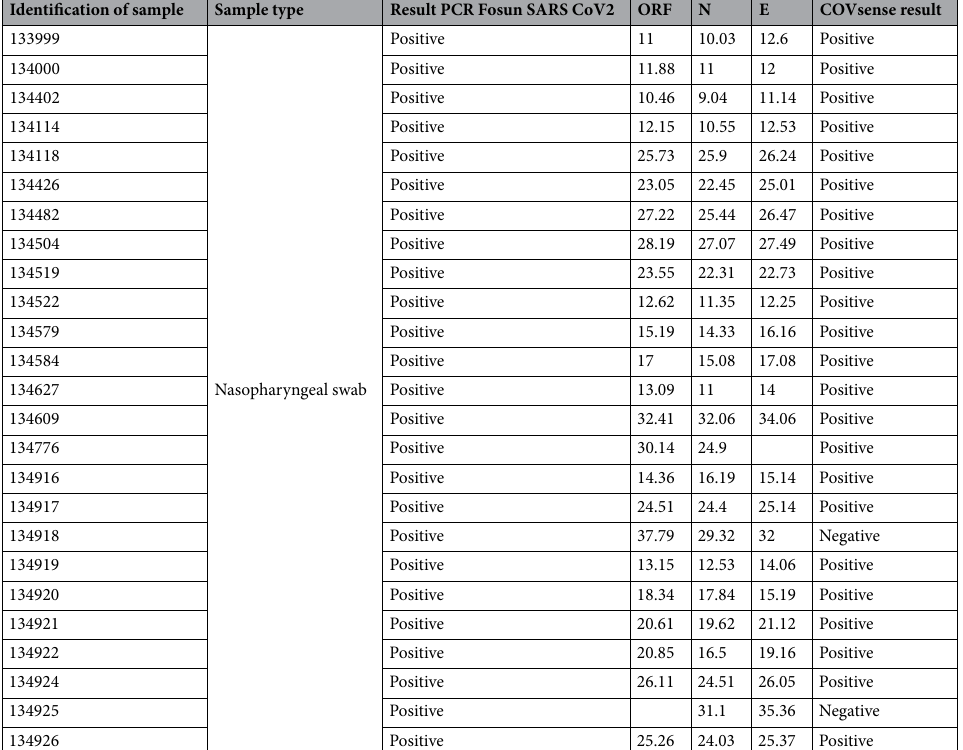
Table 4. Comparison between positive clinical samples tested by RT-qPCR and our testing method. Cycle thresholds are represented under the specific amplified region ORF/N/E.COVsense testing method compared to the gold-standard technique.